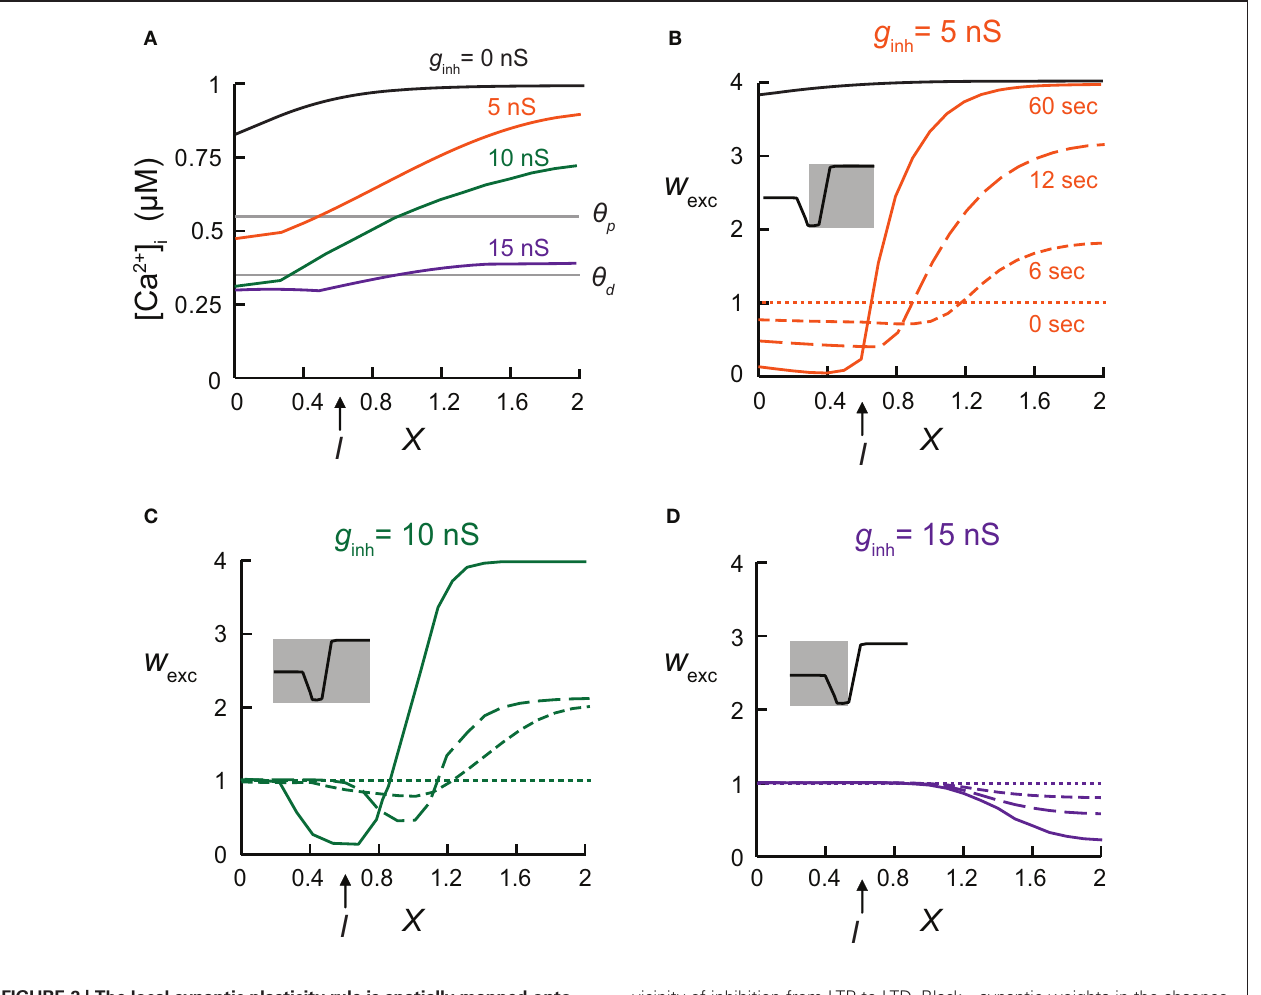
FIGURE 2 | The local synaptic plasticity rule is spatially mapped onto the dendrites. (A) Calcium concentration, [Ca 2 + ] i , for the model shown in Figure 1C , at various electrical distances from the soma with inhibitory conductance, g GABA , of 0nS (black), 5nS (orange), 10nS (green), and 15nS (purple). (B–D) Synaptic weights following 0, 6, 12, and 60s of simulation, with the [Ca 2 + ] i -dependent plasticity rule depicted in Figure 1 . Inhibition was activated at X = 0 . 6. Insets demonstrate which of the three states comprising the plasticity rule is mapped onto the dendritic cable. (B) Small GABAergic conductance ( g GABA = 5nS) switched synaptic plasticity in the